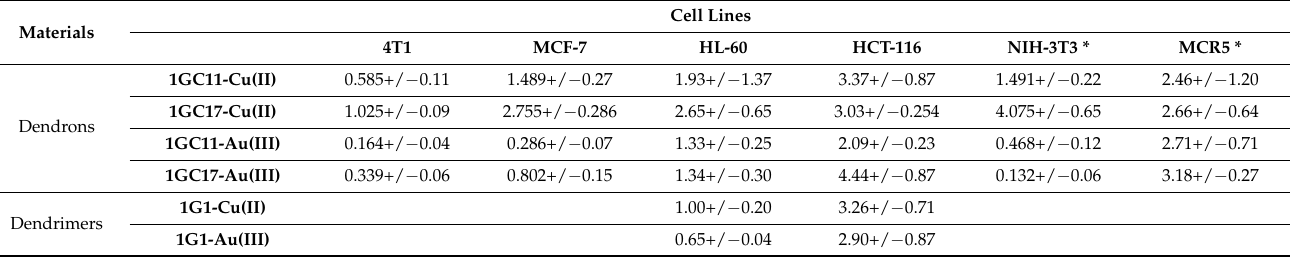
Table 1. Anti-proliferative activities of 1GC11-Cu(II) , 1GC17-Cu(II) , 1GC11-Au(III) , 1GC17-Au(III) , 1G1-Cu(II) and 1G1- Au(III) .